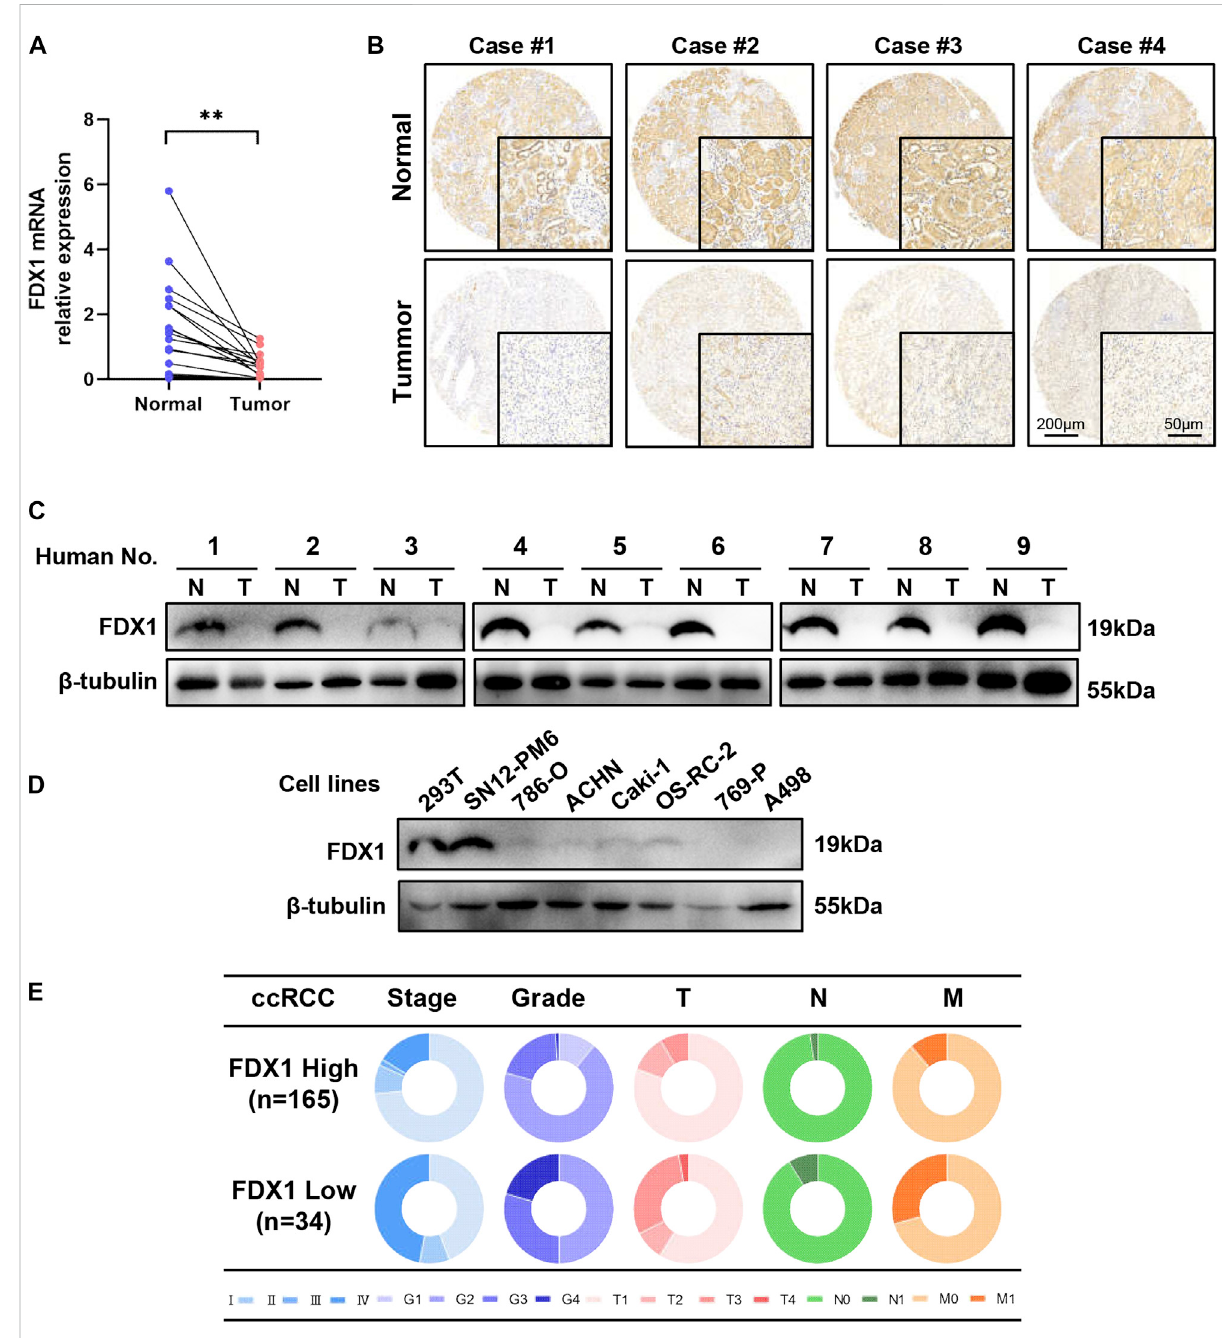
FIGURE 4 FDX1 is overexpressed in normal tissues and downregulated in ccRCC and cell lines. (A) RT-qPCR analysis of FDX1 mRNA expression between normalandtumourtissuesin27pairsofpatients ’ tissues. (B) TissuemicroarrayanalysisbyIHCwasperformedtoevaluatetheproteinexpressionlevel of FDX1 in para-tumorous normal tissue and primary tumour tissue from 199 patients. (C) FDX1 protein expression between normal and cancerous specimens was investigated by a western blot analysis. (D) Immunoblotting assay of FDX1 protein expression in ccRCC cell lines and 239T control cell lines. (E) The circular pie chart illustrates the proportional fl uctuation of clinical parameters (including AJCC stage, ISUP grade, tumour size, node, and metastasis stages) in the FDX1-high and FDX1-low expression groups in TMA with 199 patients with